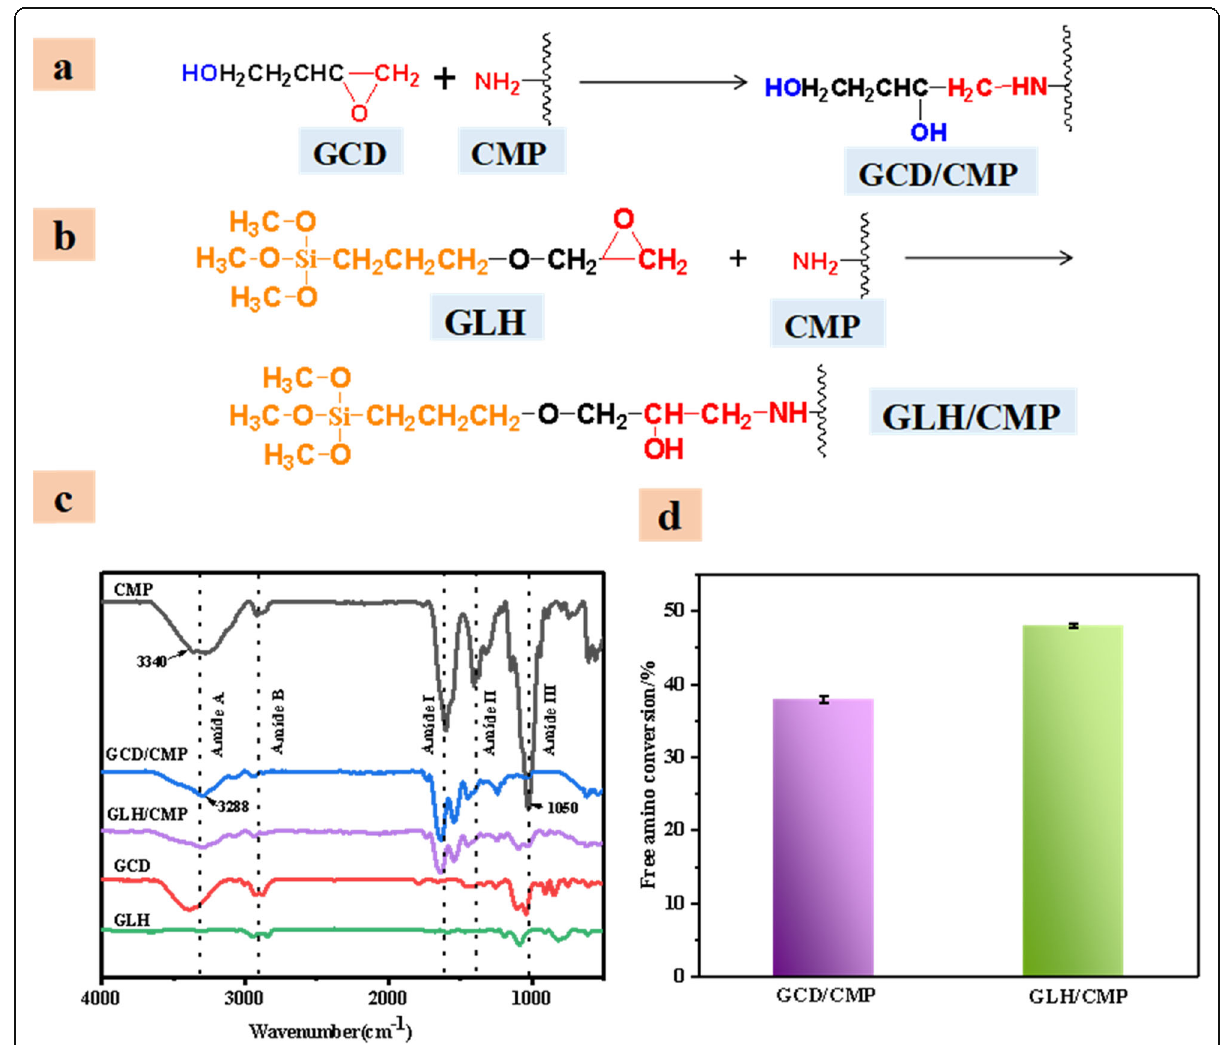
Fig. 1 Synthesis routesof a GCD/CMP and b GLH/CMP. c FT-IR spectrum. d Amino conversion rates under optimization